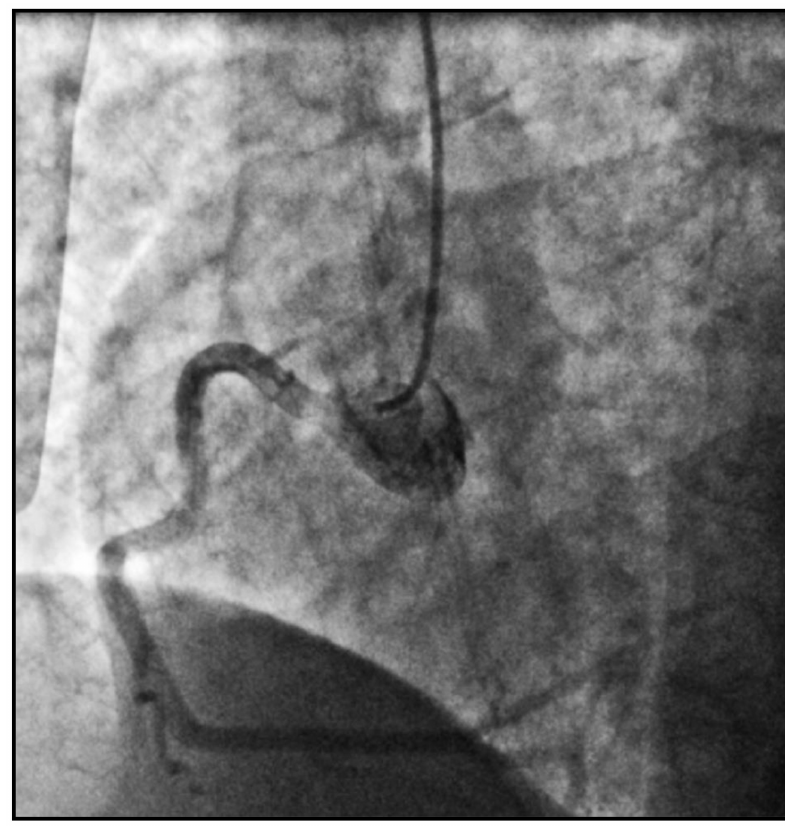
Figure 1. A coronary angiogram of the right coronary artery